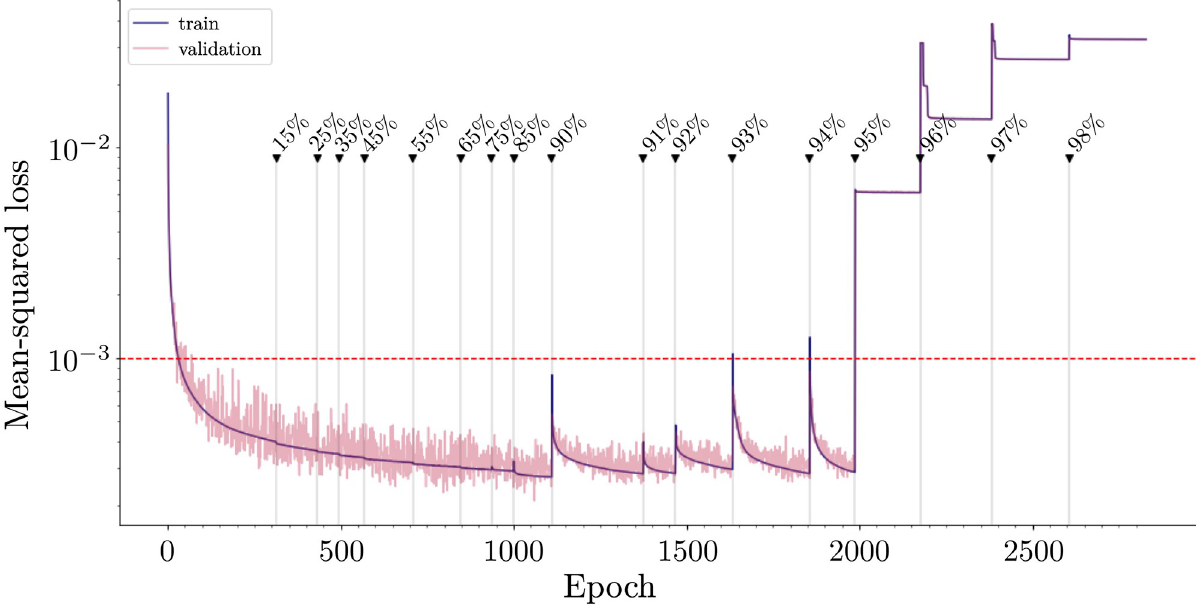
Fig 2. Learning curve for sequential pruning of network. Fully-connected neural network is trained until the mean-squared error is minimized. Then, the network is sequentially pruned by adding in masking layers and trained again. The performance of the network improves below the minimum error achieved by the fully-connected network for low levels of pruning, but performs comparably to the fully-connected network until 94% of the network is pruned.